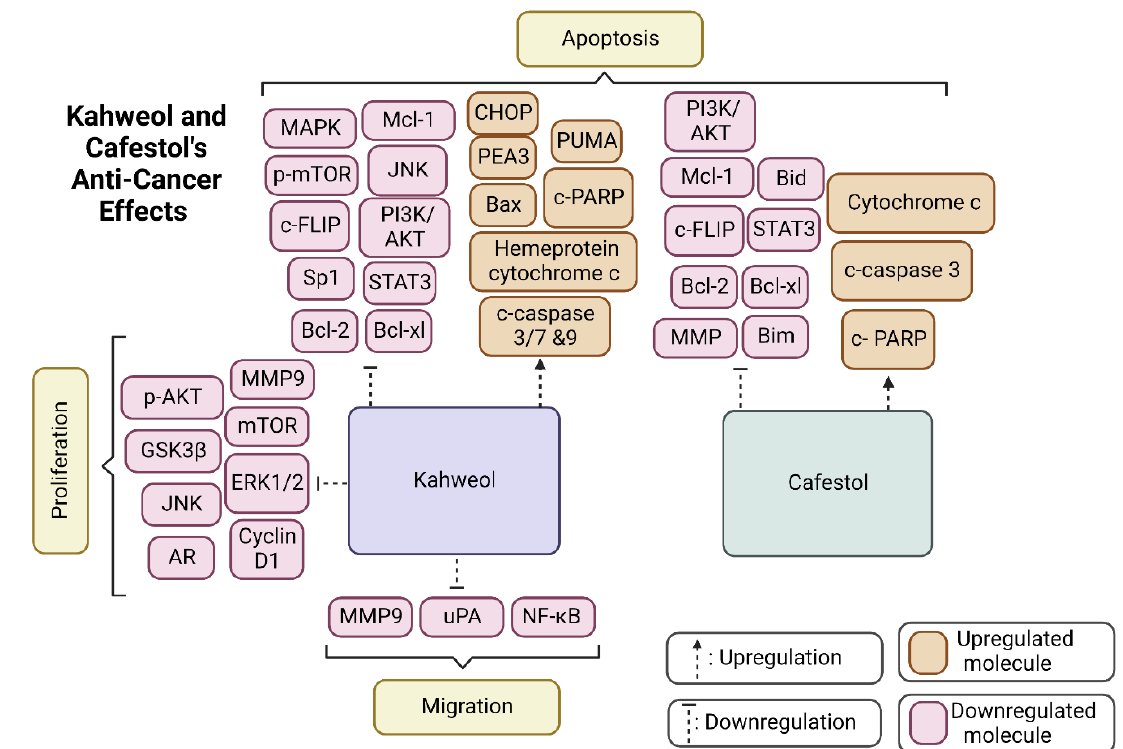
Figure 3. The diagram summarises kahweol and cafestol’s effects on anticancer pathways, including migration, proliferation, and apoptosis. Created by BioRender.com.